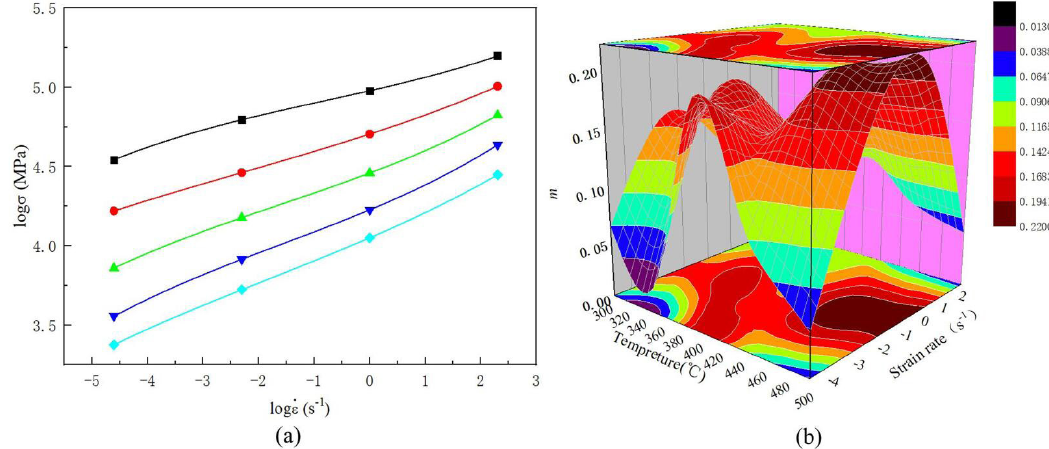
Figure 10. (a) the fitting relationship of log ε  and log σ under the strain of 0.9; (b) the 3D response surface map of m -values.